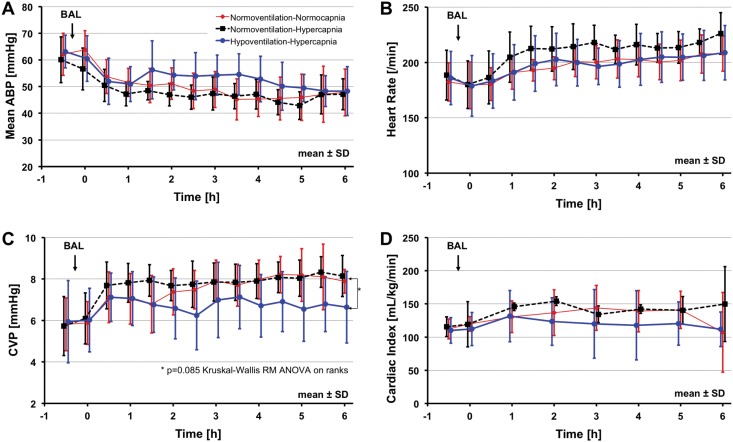
Hemodynamic parameters over time: Arterial blood pressure [A], heart rate [B], central venous pressure [C] and cardiac index [D] over experimental time.Time = 0 refers to time of randomization. BAL = bronchoalveolar lavage. There were no significant differences between groups.